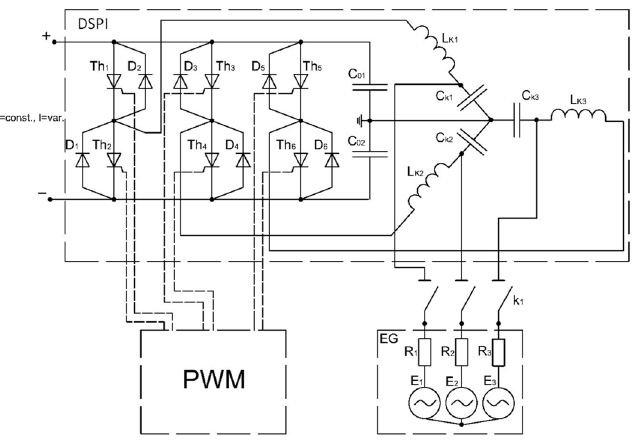
Figure 1. Dual system, three-phase power inverter diagram (DSPI—the dual system three-phase power inverter, EG—electricity grid, PWM—pulse with modulator).